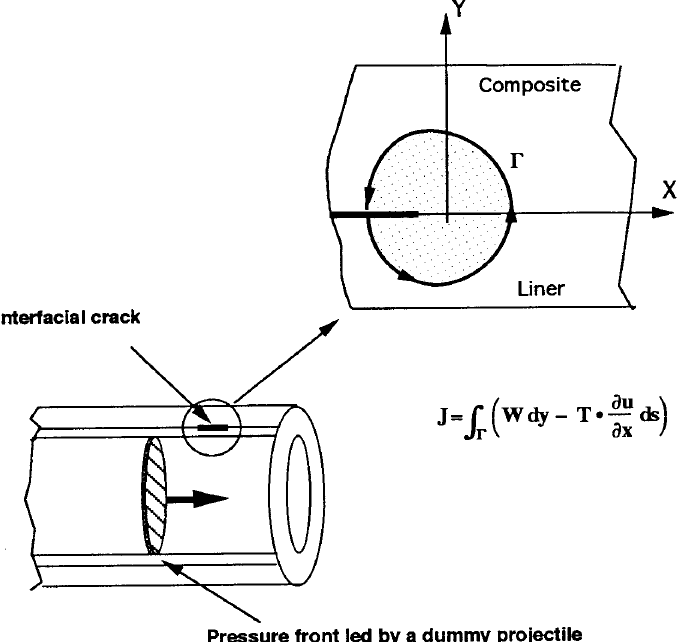
Fig. 1. Energy integration defined along an interface